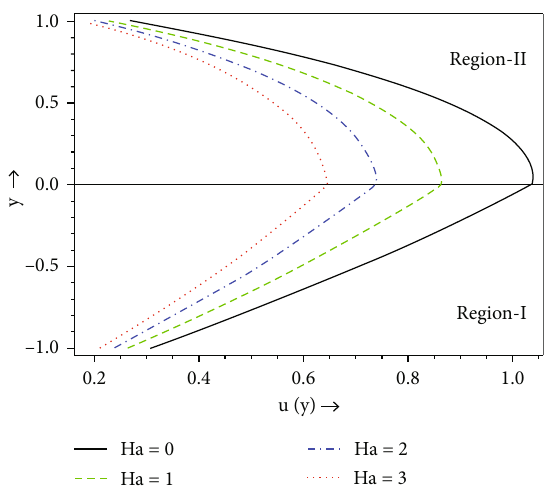
Figure 4: E ff ect of Hartmann number Ha on velocity 1 on velocity